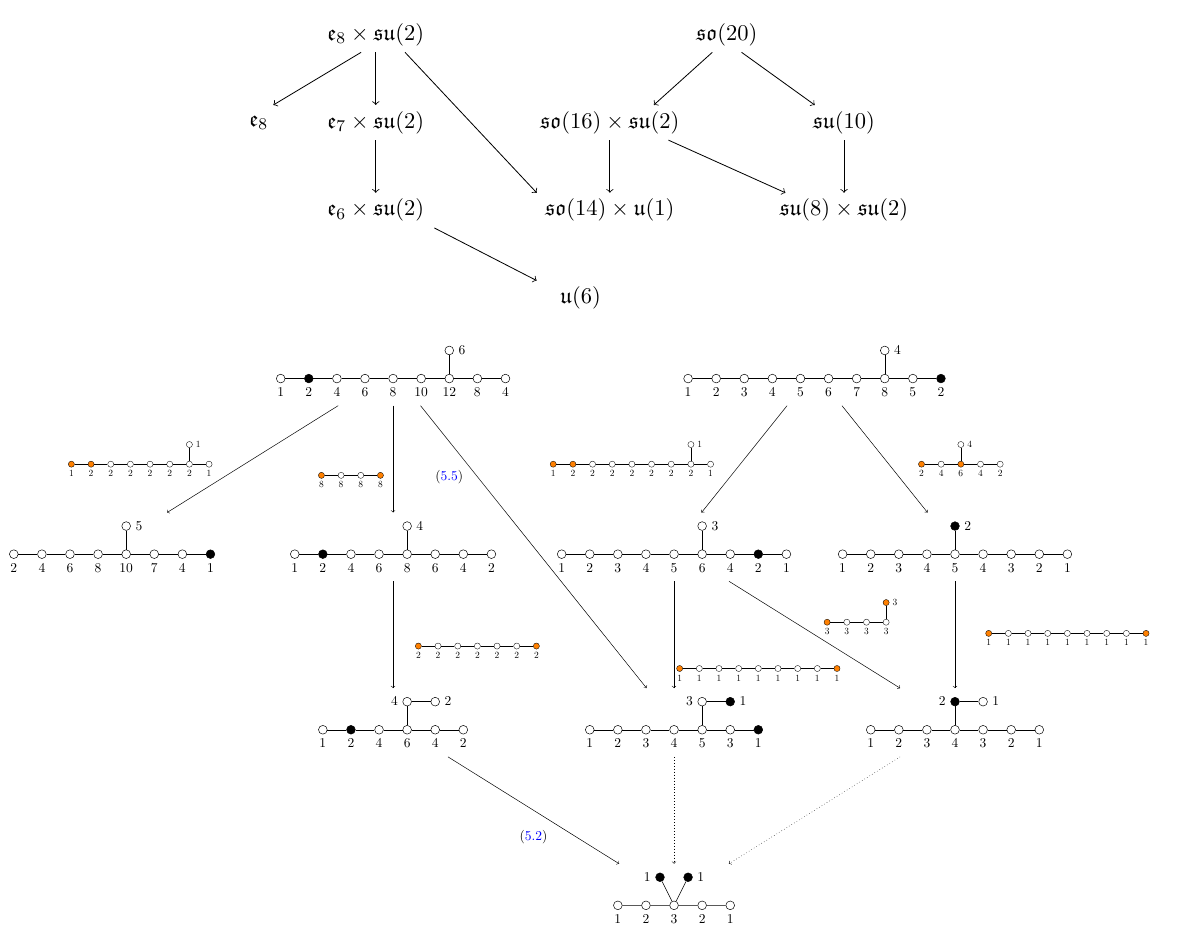
Figure 12 . Top: part of the graph of mass deformation for 4d N = 2 SCFTs of rank 2. We stop at the point where the theories become Lagrangian (here the SU(3) SQCD theory). Bottom: corresponding graph of magnetic quivers, along with the solutions to be subtracted to implement the mass deformations. Most subtractions are straightforward. The non-trivial ones are discussed in the